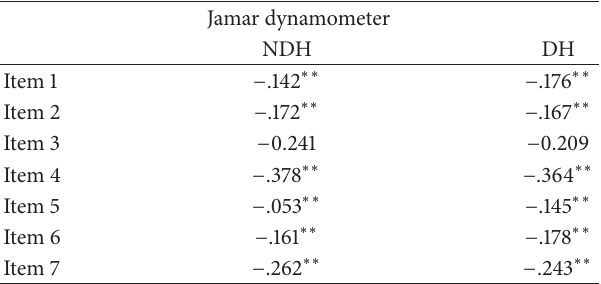
Table 4: Pearson’s correlation for construct